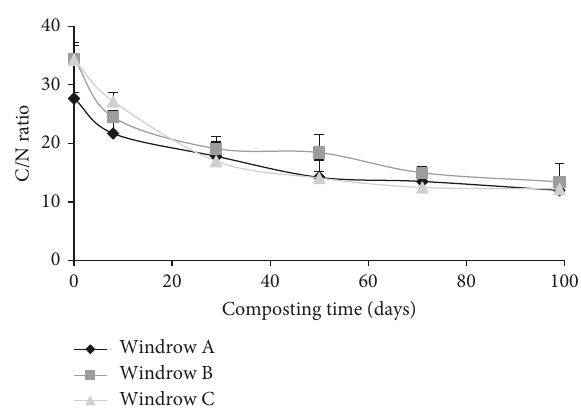
Figure 5: The C/N ratio evolution during the composting Table 4: Physicochemical characteristics of produced composts. Parameters